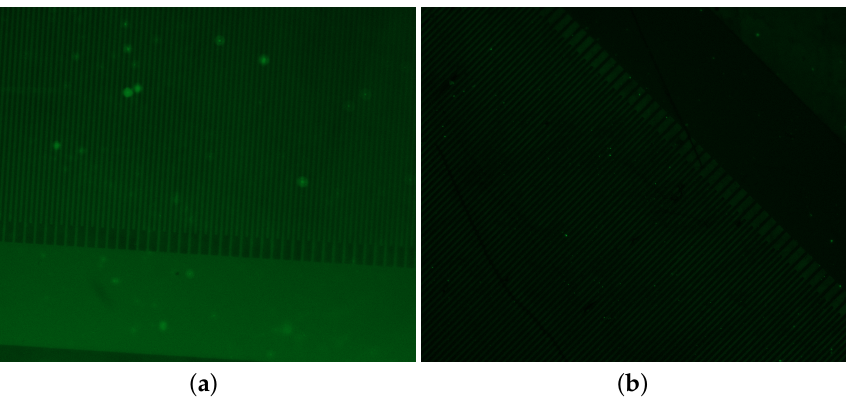
Figure 3. Microscopy results validating antibody immobilization. ( a ) IDE with an immobilized antibody. ( b ) Control IDE without an immobilized antibody.